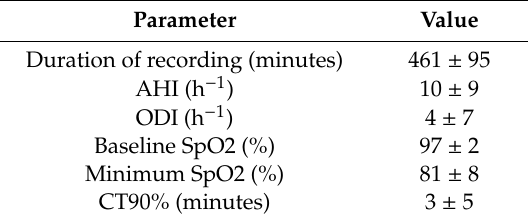
Table 2. Respiratory variables of the whole study sample.